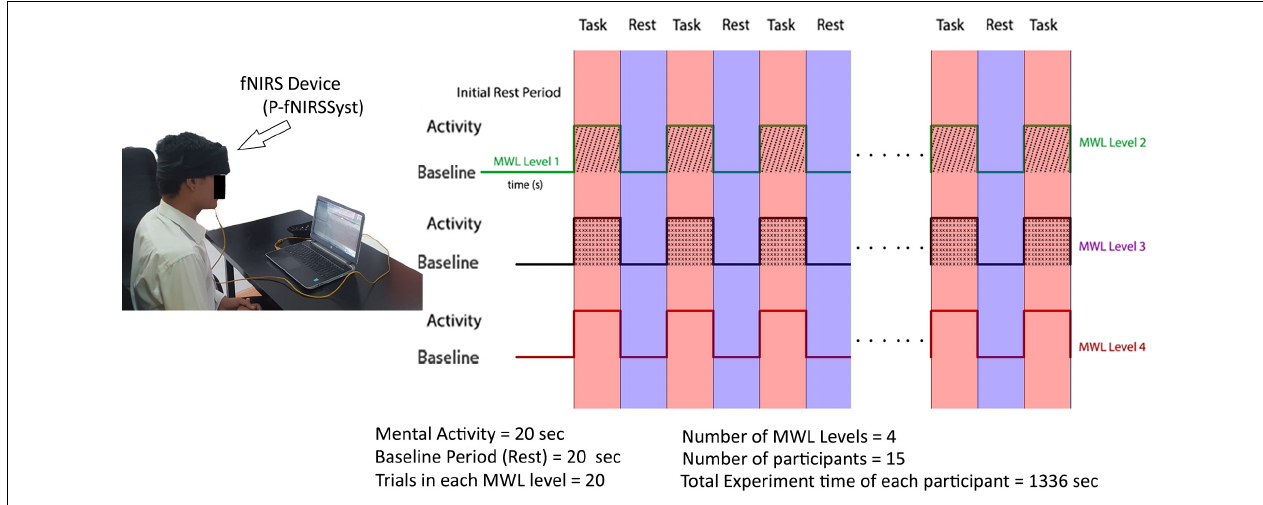
FIGURE 3 | Data acquisition and experimental paradigm with experimental trials and trial sequence diagram. After initial rest period, participants are presented through mental workload (MWL) tasks in phases with increasing difficulty